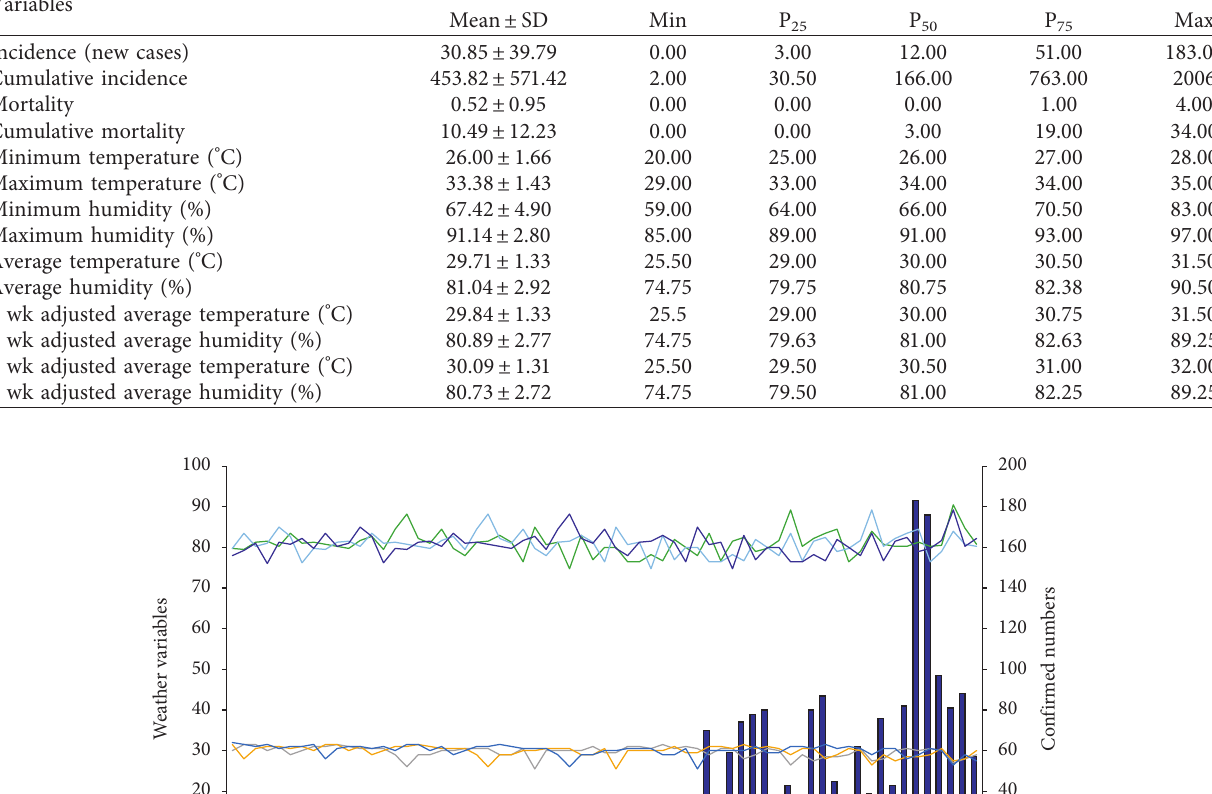
Table 1: Summary of COVID-19 pandemic and meteorological factors in Lagos, Nigeria (9 th March to 12 th May 2020). Variables